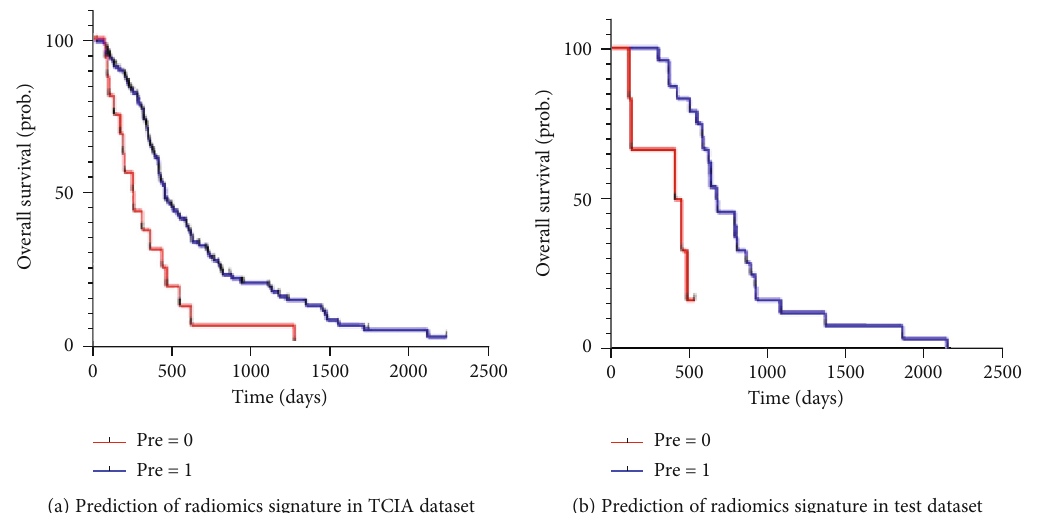
Figure 5: Using Kaplan-Meier analysis to verify the performance of radiomics signature. The response ability of GBM patients to radiotherapy was successfully divided into the high-risk group (radiotherapy resistance group, pre = 0 ) and low-risk group (radiotherapy e ff ective group, pre = 1 ) according to the prediction results of radiomics signature. There were signi fi cant di ff erences in TCIA (a) and test (b) datasets between the high-risk group and the low-risk